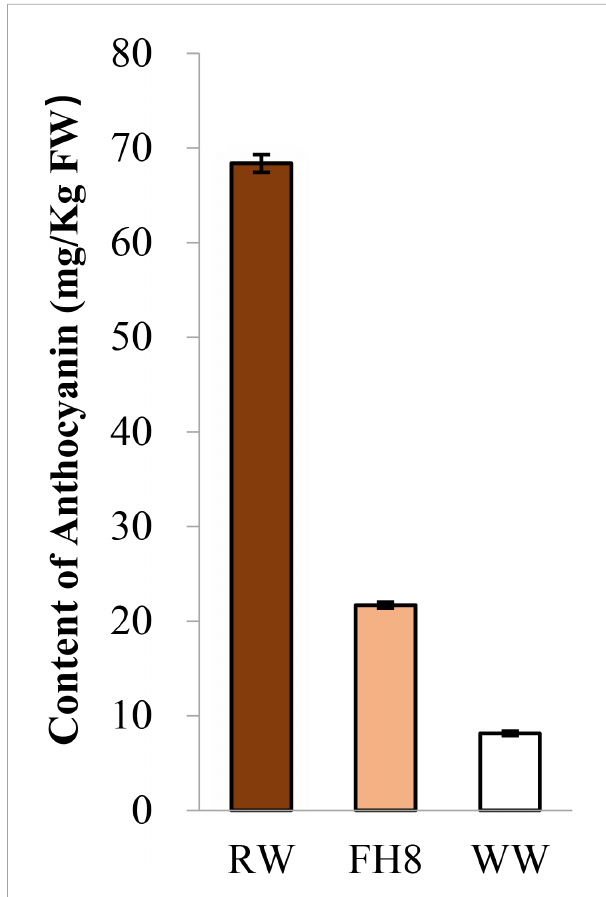
FIGURE 1 Comparison of the anthocyanin content in testa from different testa pigmentation pattern peanut germplasm. Red zone on Wc (RW), white zone on Wc (WW), and pink zone on Fuhua